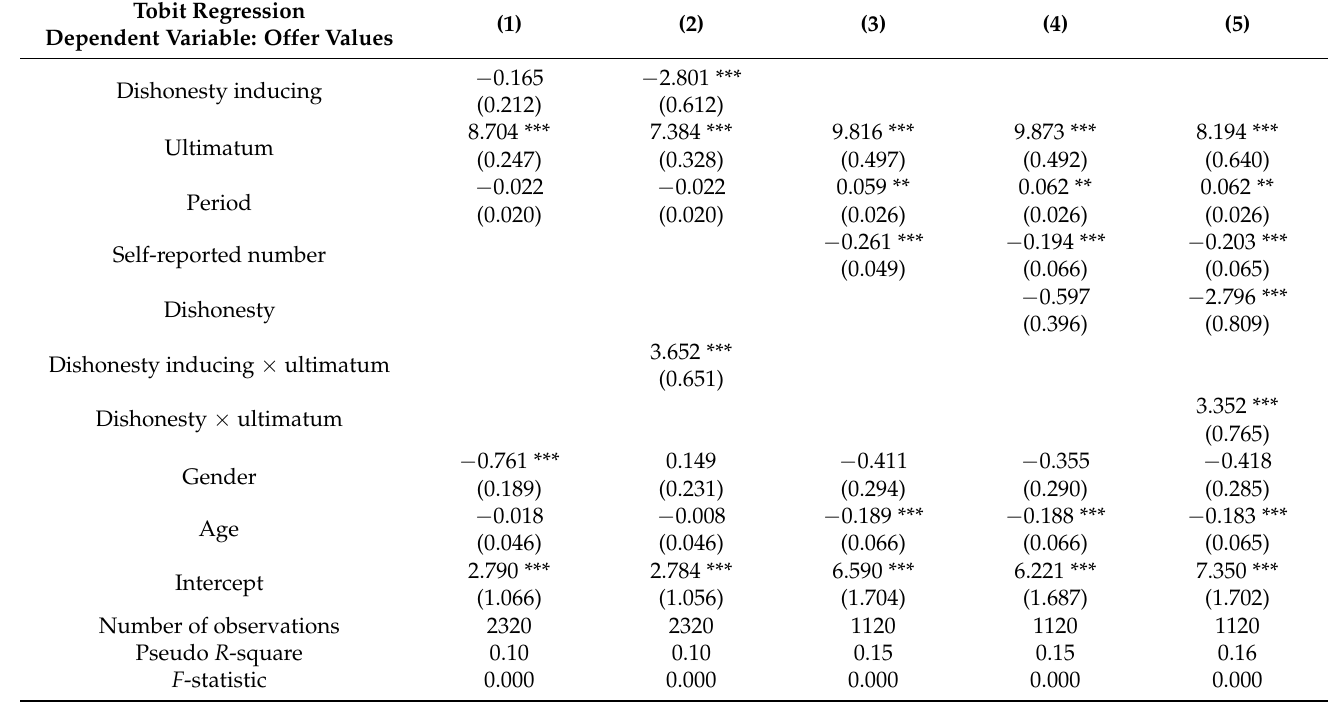
Table 3. Tobit regression on money given to